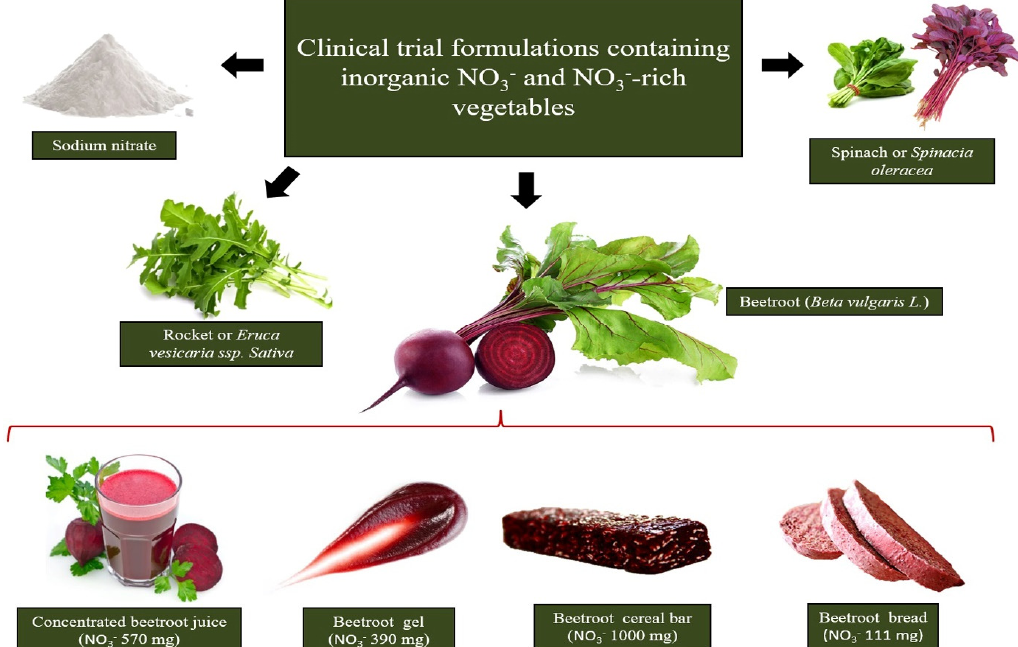
Figure 1. The richest sources of dietary NO 3 − tested in clinical interventions are beetroot, rocket and spinach. Beetroot formulation choice to supplement dietary NO 3 − relies on the design of beetroot-derived formulations containing pharmacological NO 3 − doses in a small serving portion.